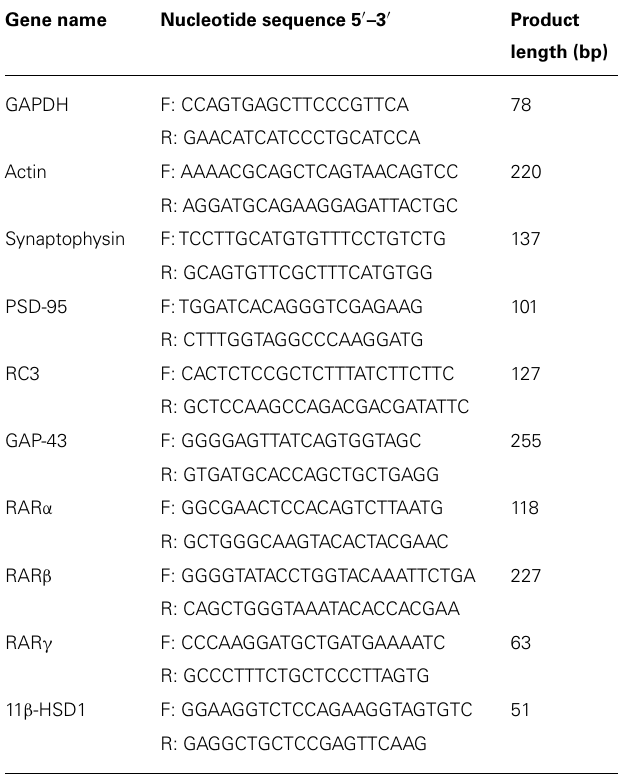
Table 1 | Primers used for LightCycler